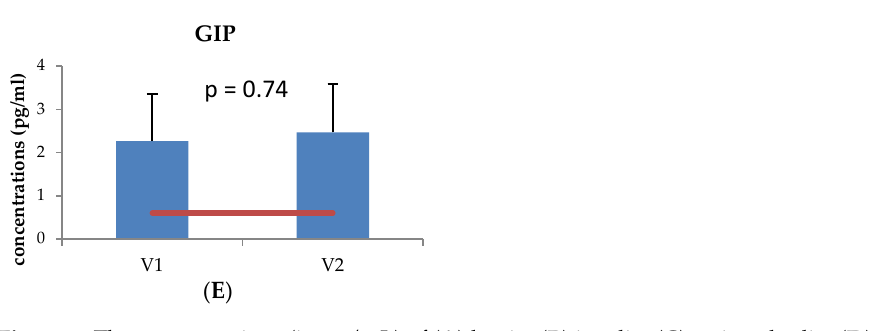
Figure 1. The concentrations (in pg/mL) of ( A ) leptin, ( B ) insulin, ( C ) active ghrelin, ( D ) C-peptide and ( E ) GIP were expressed as mean ± S.D. for each visit, V1 and V2. The red horizontal line shows the MinDC.